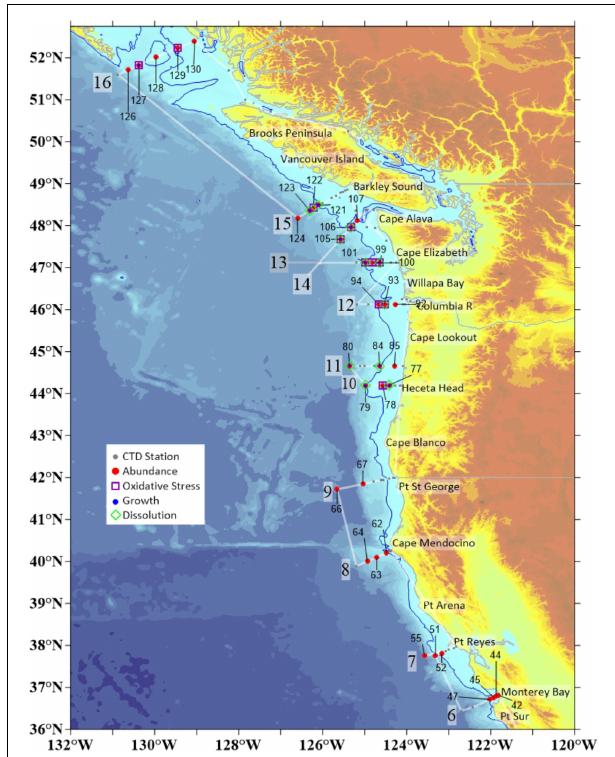
FIGURE 2 | Stations in the CCS at which physical–chemical data matched variety of different biological parameters measured in pteropods, including shell dissolution, oxidative stress, length measurements, and abundance. We investigated the responses along 11 of 17 transect lines that comprised the entire cruise. Individual station numbers are aligned with characteristic biological measurements. CTD measurements were taken on all stations where biological data were